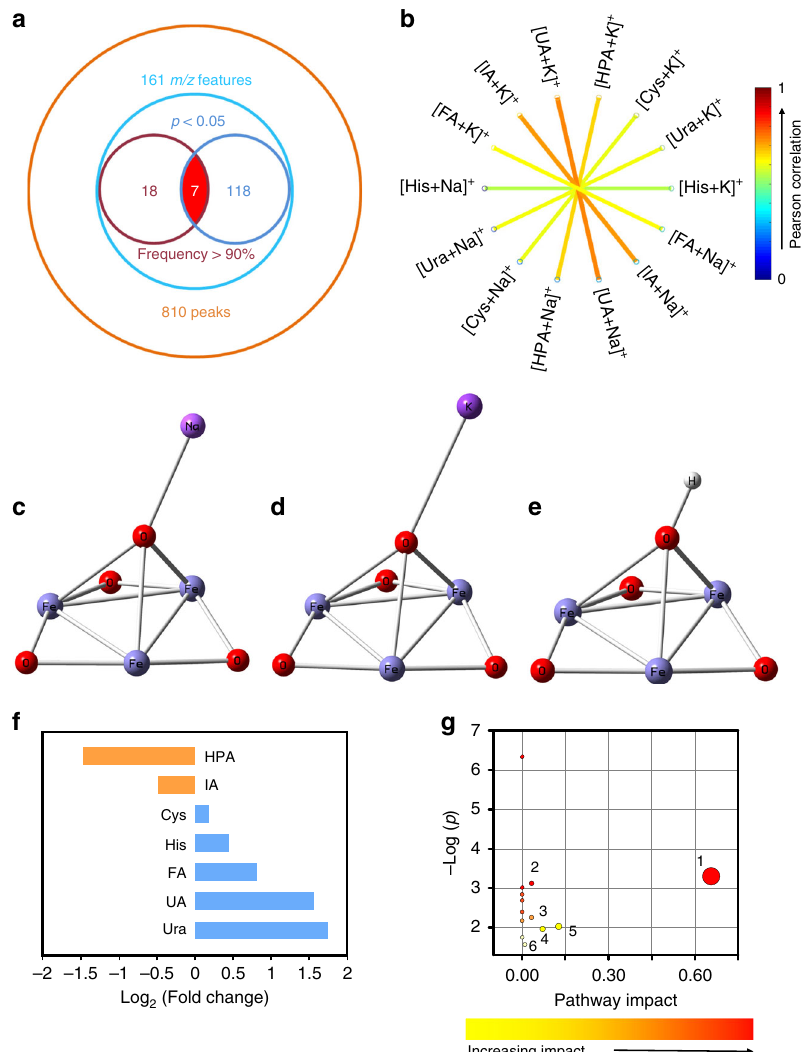
Fig. 4 Construction of metabolic biomarker panel. a Venn diagram of 161 m / z features from 810 metabolite peaks in serum, seven of which were selected as potential biomarkers with both model selection frequency >90% and p < 0.05 (<400 Da). b Correlation network plot elucidating strong Pearson correlation (>0.5) between Na + -adducted and K + -adducted signals (along diagonal line) for all seven selected metabolites in serum. Binding af fi nity of cations on the exposed surface [1,1,1] of ferric particles. Density functional theory (DFT) calculation results of c [ferric particles + Na + ], d [ferric particles + K + ], and e [ferric particles + H + ] system with an anionic cluster model in the minimum-energy structure. f Fold change of fi ve up-regulated metabolites (blue) and two down-regulated metabolites (orange) in early-stage LA patients compared with healthy controls. g Potential pathways differentially regulated in early-stage LA patients and healthy controls. The seven selected metabolites were tested to identify altered pathways. The colour and size of each circle were correlated to the p value and pathway impact value. A total of six pathways were differentially regulated: (1) fatty acid metabolism, (2) sulfur metabolism, (3) histidine metabolism, (4) cysteine and methionine metabolism, (5) pyrimidine metabolism, and (6) purine metabolism. Pathways with impact values >0 were considered to be differentially altered between early-stage LA patients and healthy controls. Source data are provided as a Source Data fi